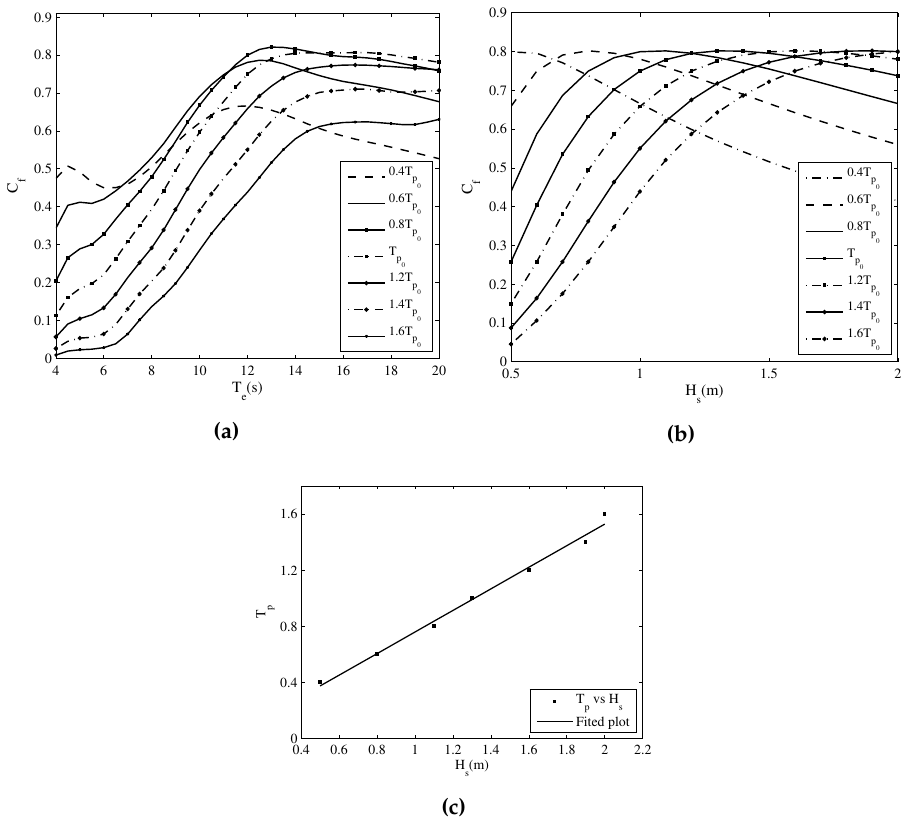
Figure 15. Variation of C f with ( a ) T e ; ( b ) H s for different loading conditions; and ( c ) Optimum loading conditions for maximum C f for different H s